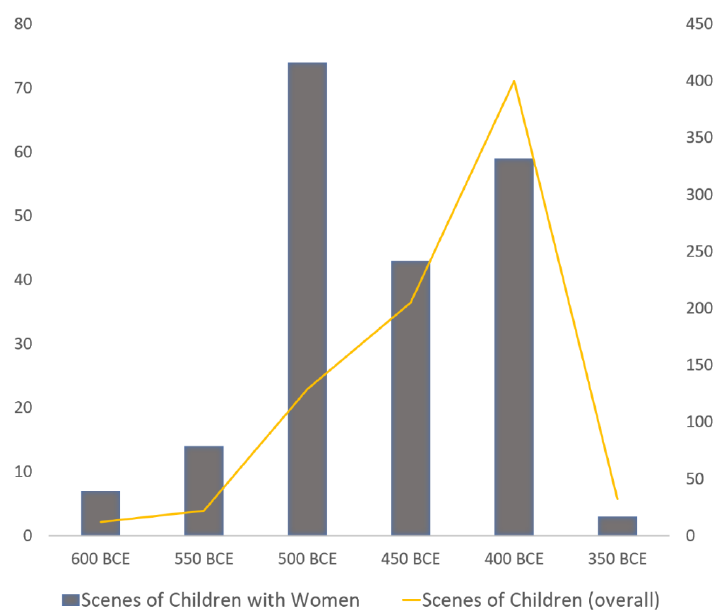
Figure 12. Chart illustrating relative numbers of select scene types featuring women, including all known provenances. Data from the BAPD. Chart created by author.